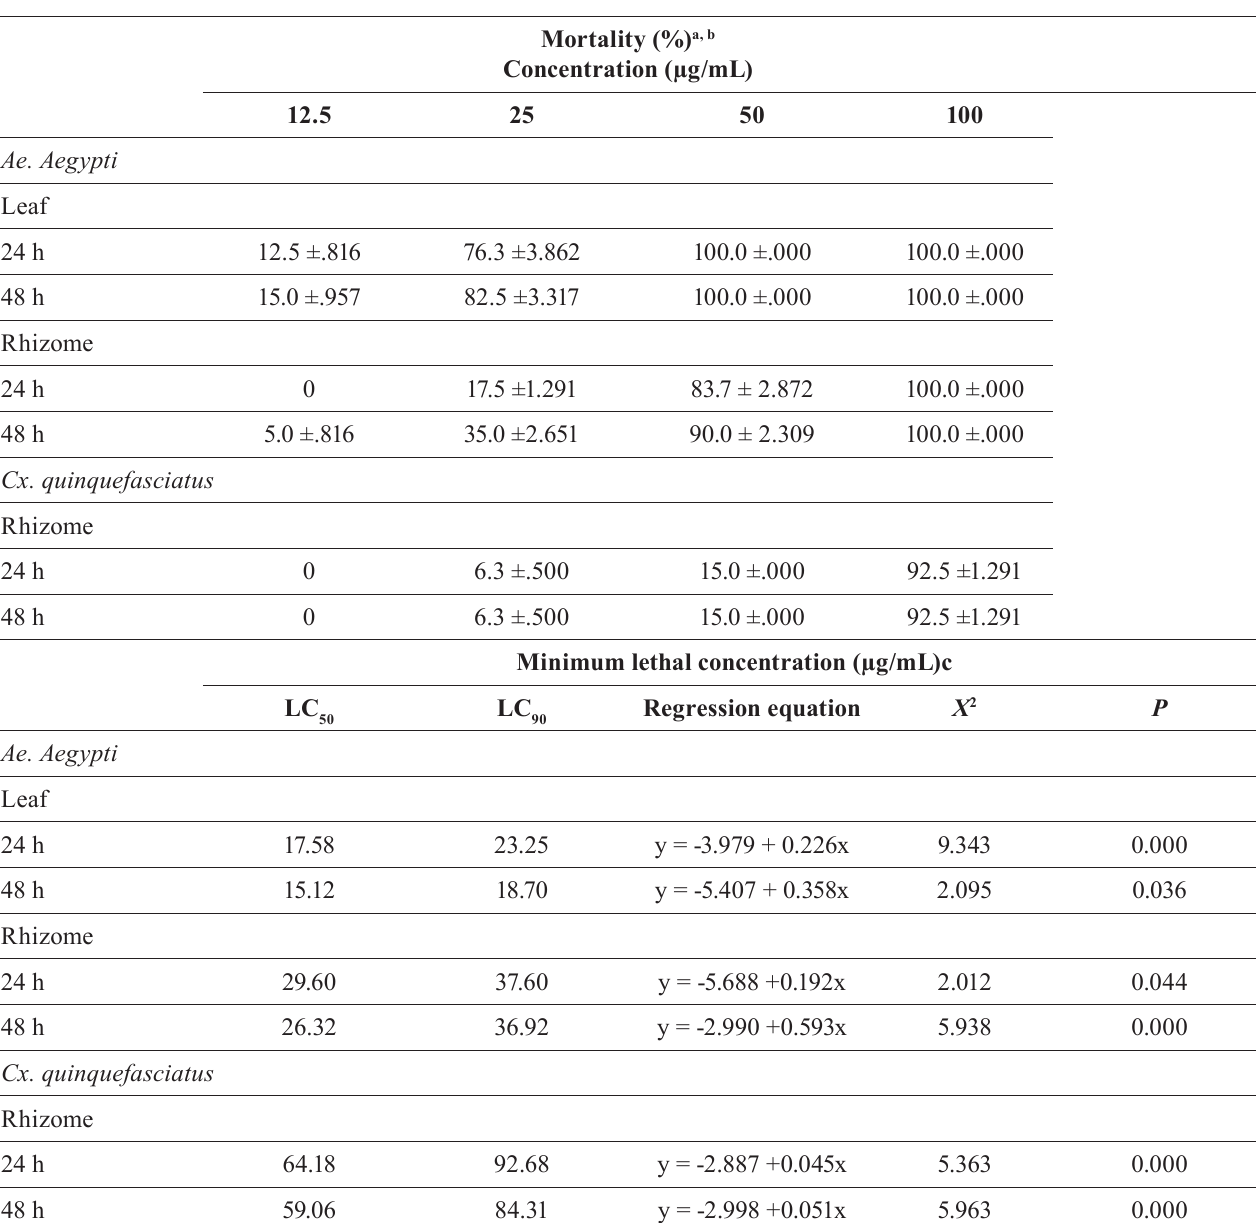
TABLE III - Mortality and larvicidal action of Z. nitens leaf and rhizome